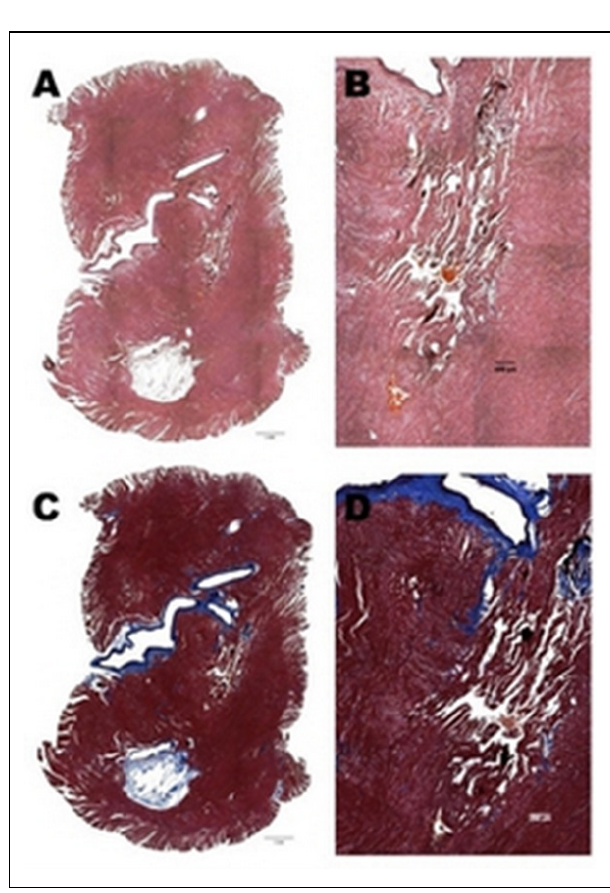
Fig. 5 - Histological samples. The results are presented through microscopic aspects of the heart. A and B - Hematoxylin-eosin; C - Masson; and D - Evans